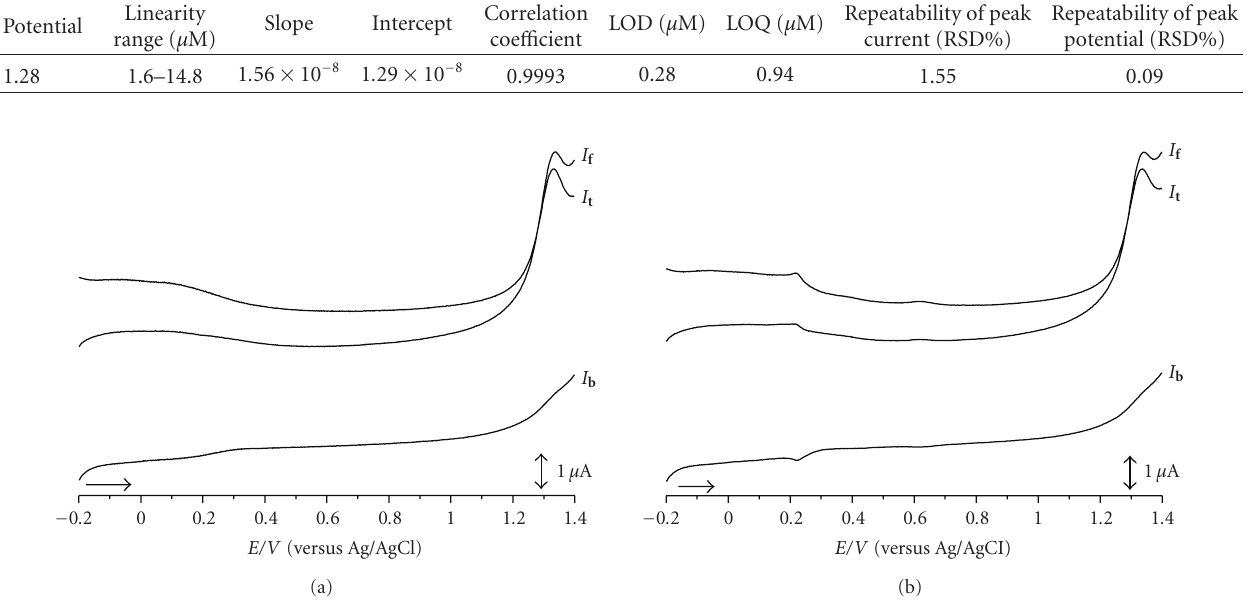
ν = 100mVs − 1 . e ff ective